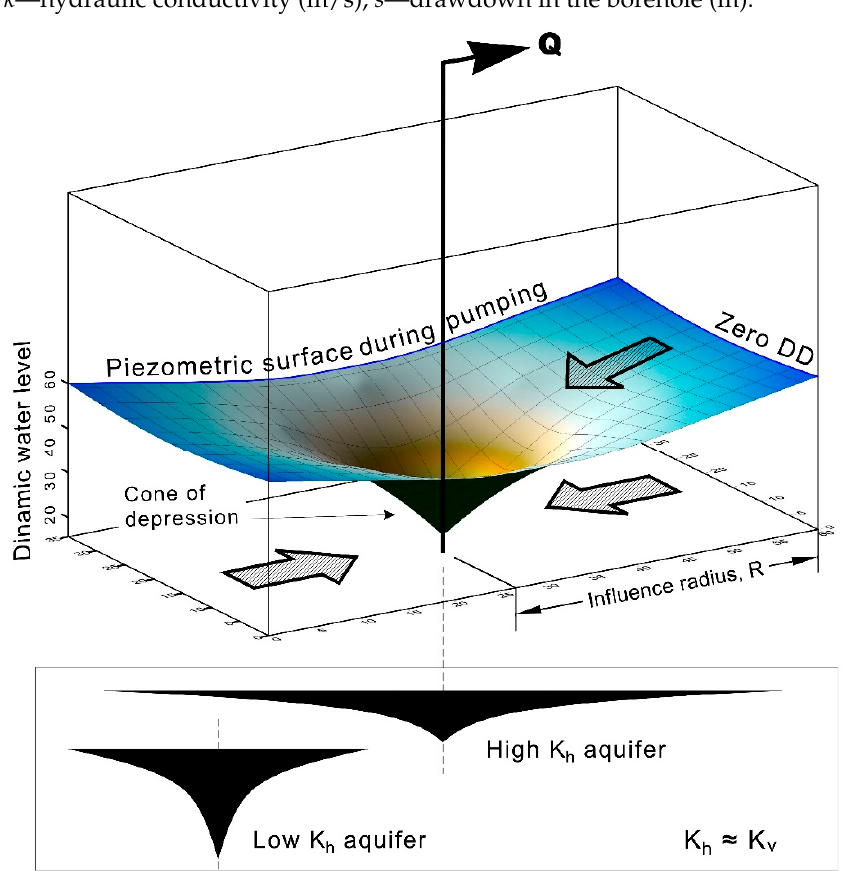
Figure 5. Diagram of a cone of depression and influence radius for pumping wells.